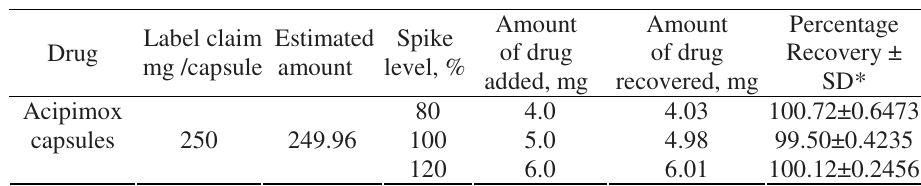
Table 3 . Recovery